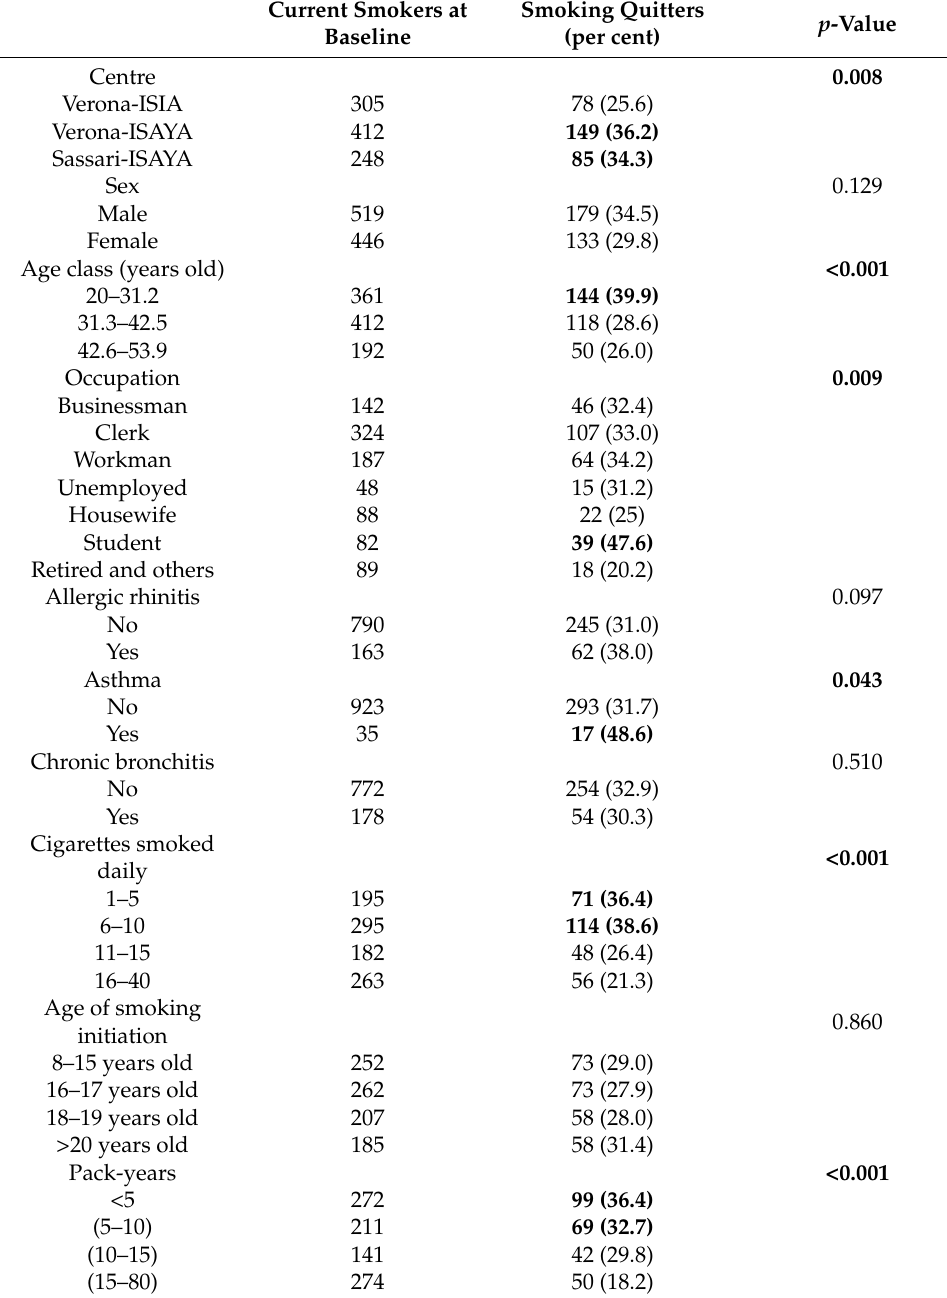
Table 2. Smoking cessation in a sample of 965 subjects who were current smokers at the baseline. Current Smokers